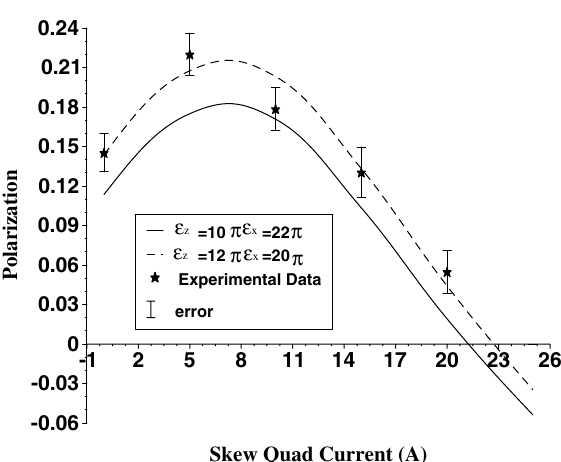
and 0 (cid:5) (cid:28) u v FIG. 5. Polarization after crossing the 0 (cid:5) (cid:28) (cid:3) 8 : 8 and (cid:28) (cid:3) 8 : 78 versus resonances with set-point vertical normal mode tune ( (cid:28) v u 8 : 8 ) versus horizontal set tunes. Snake strength was 3%.Vertical and horizontal emittances were measured as (cid:4) 13 (cid:18) 1 (cid:6) $ and (cid:4) 21 (cid:18) 1 (cid:6) $ mm mrad , respectively. In addition, a distributed roll of < 0 : 3 mrad was applied to the BD and CF magnets in the DEPOL calculated curves.